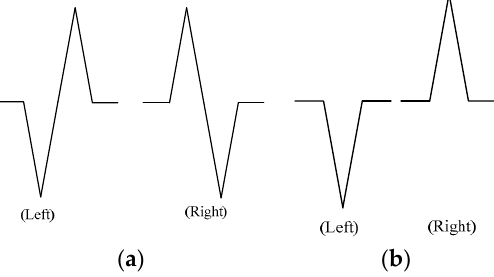
Figure 9. Pattern of lane-change ( a ) and turning ( b ).